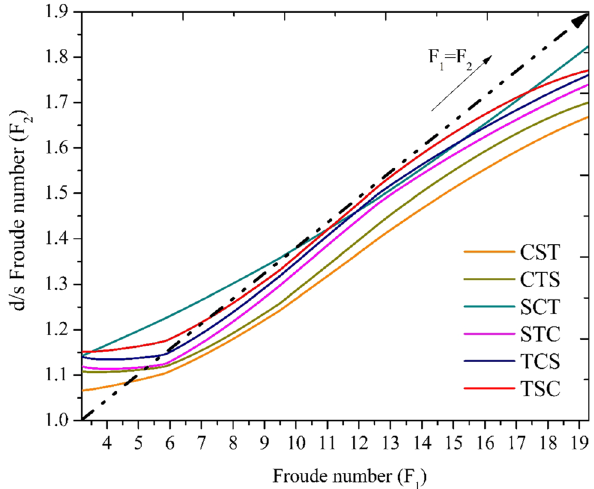
Fig. 7 Variation of downstream Froude number ( F Froude number ( F 1 )